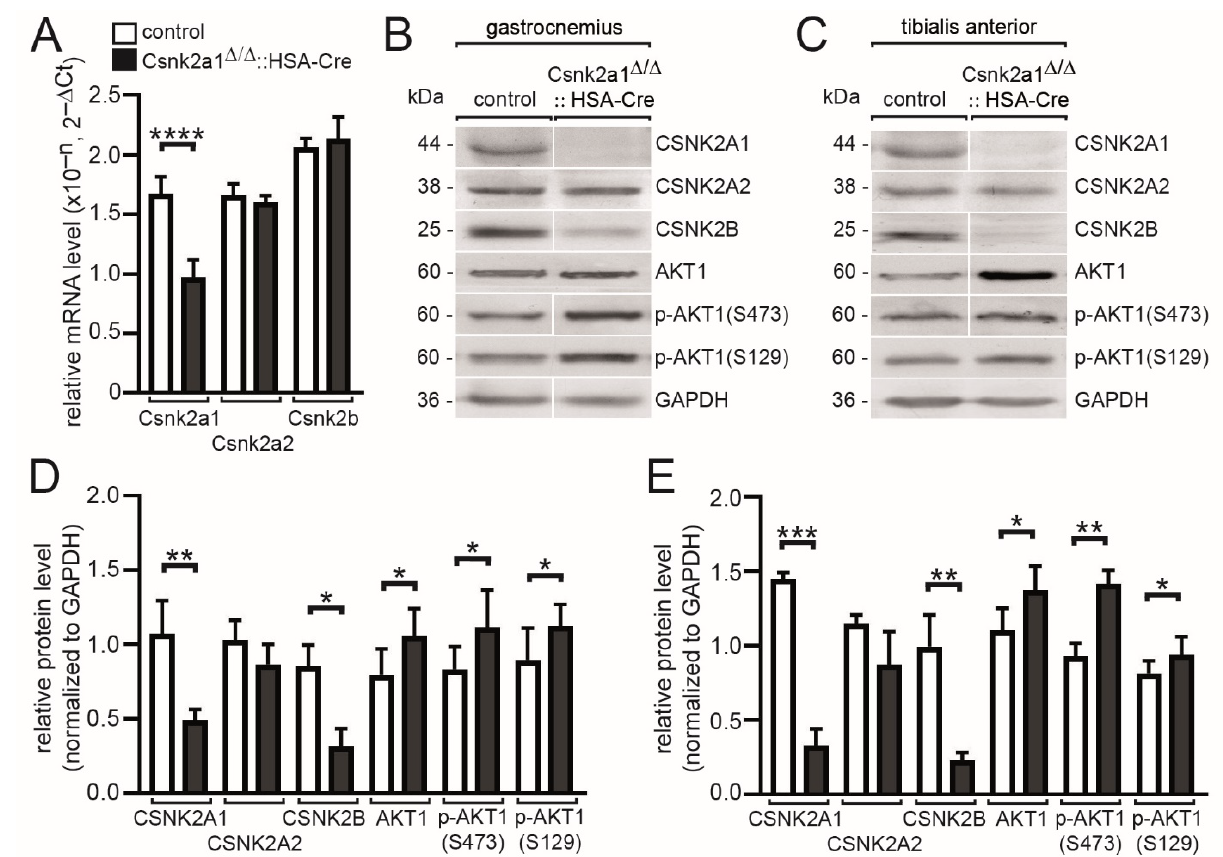
Figure 2. mRNA and protein amounts of other subunits of CSNK2 and a typical target of CSNK2, AKT1, both in conditional Csnk2a1 knockout mice. ( A ) Graph summarizes transcript amounts as detected by qPCR experiment using extracted RNA from tibialis anterior muscle of conditional Csnk2a1 knockout and control mice. ( B , C ) Images of typical Western blot membranes using muscle lysates from gastrocnemius or tibialis anterior muscles. While CSNK2A1 protein is absent in conditional Csnk2a1 knockout muscle lysates as expected, the total amount of CSNK2B is very low. CSNK2A2 protein amount appears only slightly reduced. Surprisingly, the amount of AKT1 is higher in conditional Csnk2a1 knockout muscle lysates in comparison with controls, and even the amount of phospho-AKT(S129) protein, a typical CSNK2 target, is significantly increased. ( D , E ) Graphs present densitometrical quantifications of protein amounts as detected by Western blot images, as shown in ( B , C ). All labeling of graph bars represents the genotype of mice as indicated in ( A ). Data are represented as mean ± S.D.; n ≥ 5 mice per genotype. **** p < 0.0001, *** p < 0.001, ** p < 0.01, * p < 0.05.